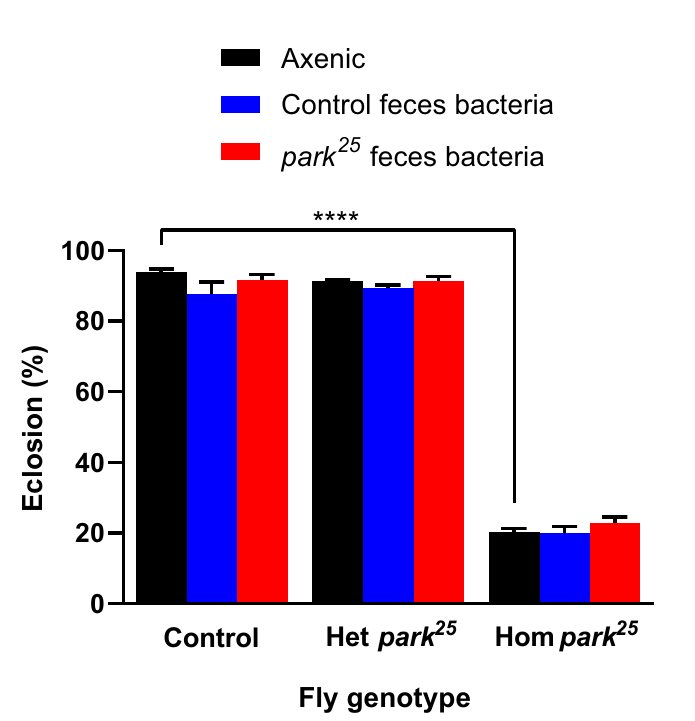
Figure 4. Axenic preparation of homozygous park 25 embryos dramatically reduces eclosion rate. Embryos from park 25 and control flies were made axenic and gnotobiotic for feces-derived bacteria from park 25 or control flies. Pupae count and eclosion was recorded from each vial. Heterozygous (Het) park 25 pupae were differentiated from the homozygous (Hom) park 25 pupae by the presence of the Tubby marker on the TM6C balancer chromosome. Data are presented as mean and SEM. Post-hoc Tukey’s analysis results are shown: **** = P < 0.0001. Sample (number of vials) sizes: Control (axenic = 40, control feces = 41, park 25 feces = 42), Het and Hom park 25 (axenic = 202, control feces = 63, park 25 feces = 59).